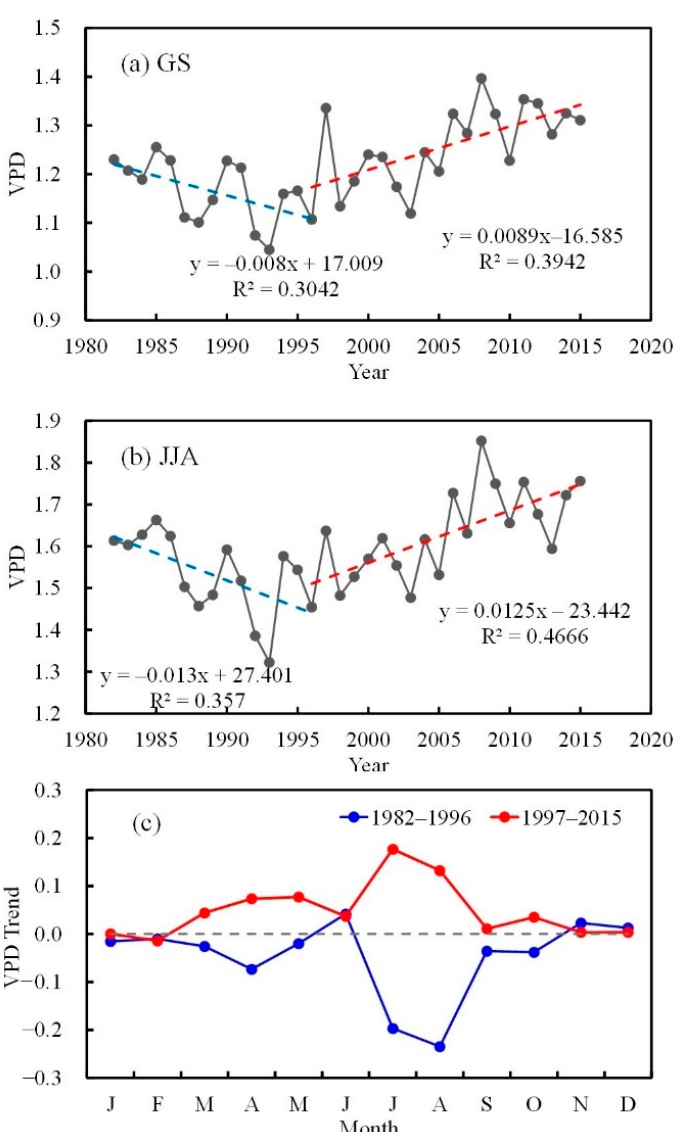
Figure 9. Change in the VPD trends over Xinjiang, China, from 1982 to 2015. ( a , b ) Time series of VPD over the GS and JJA. ( c ) Mean monthly VPD trends between the two periods of 1982–1996 and 1997–2015.